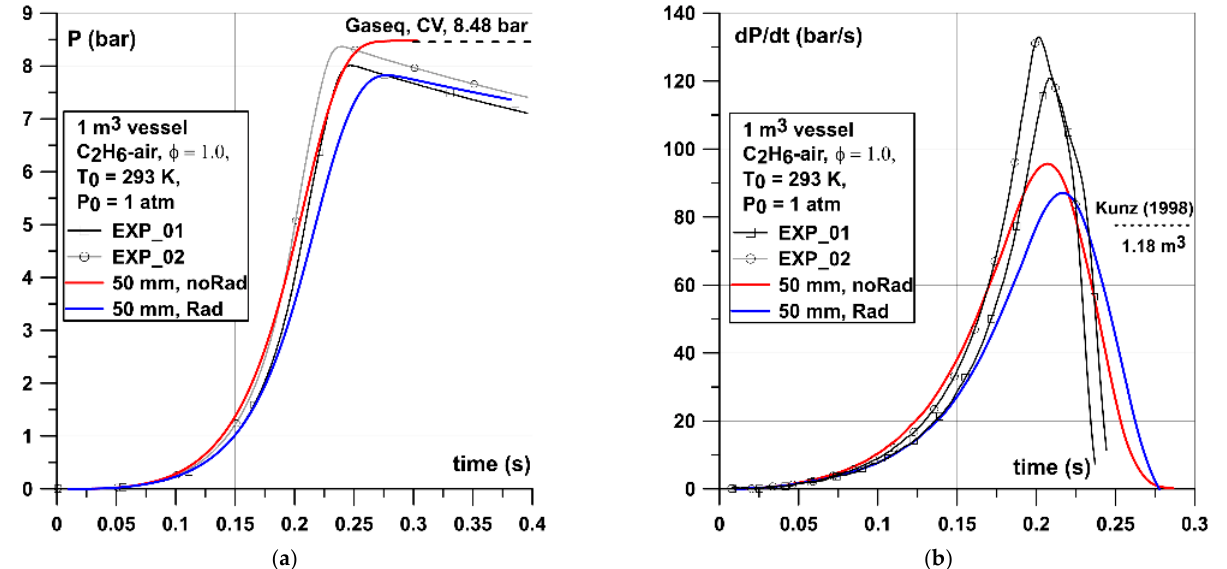
Figure 13. ( a ) Pressure and ( b ) dP/dt graphs for stoichiometric C 2 H 6 –air mixture in the 1 m 3 vessel. Dotted line mark (dp/dt) max value provided by Kunz [40] in the vessel of a similar volume and shape.